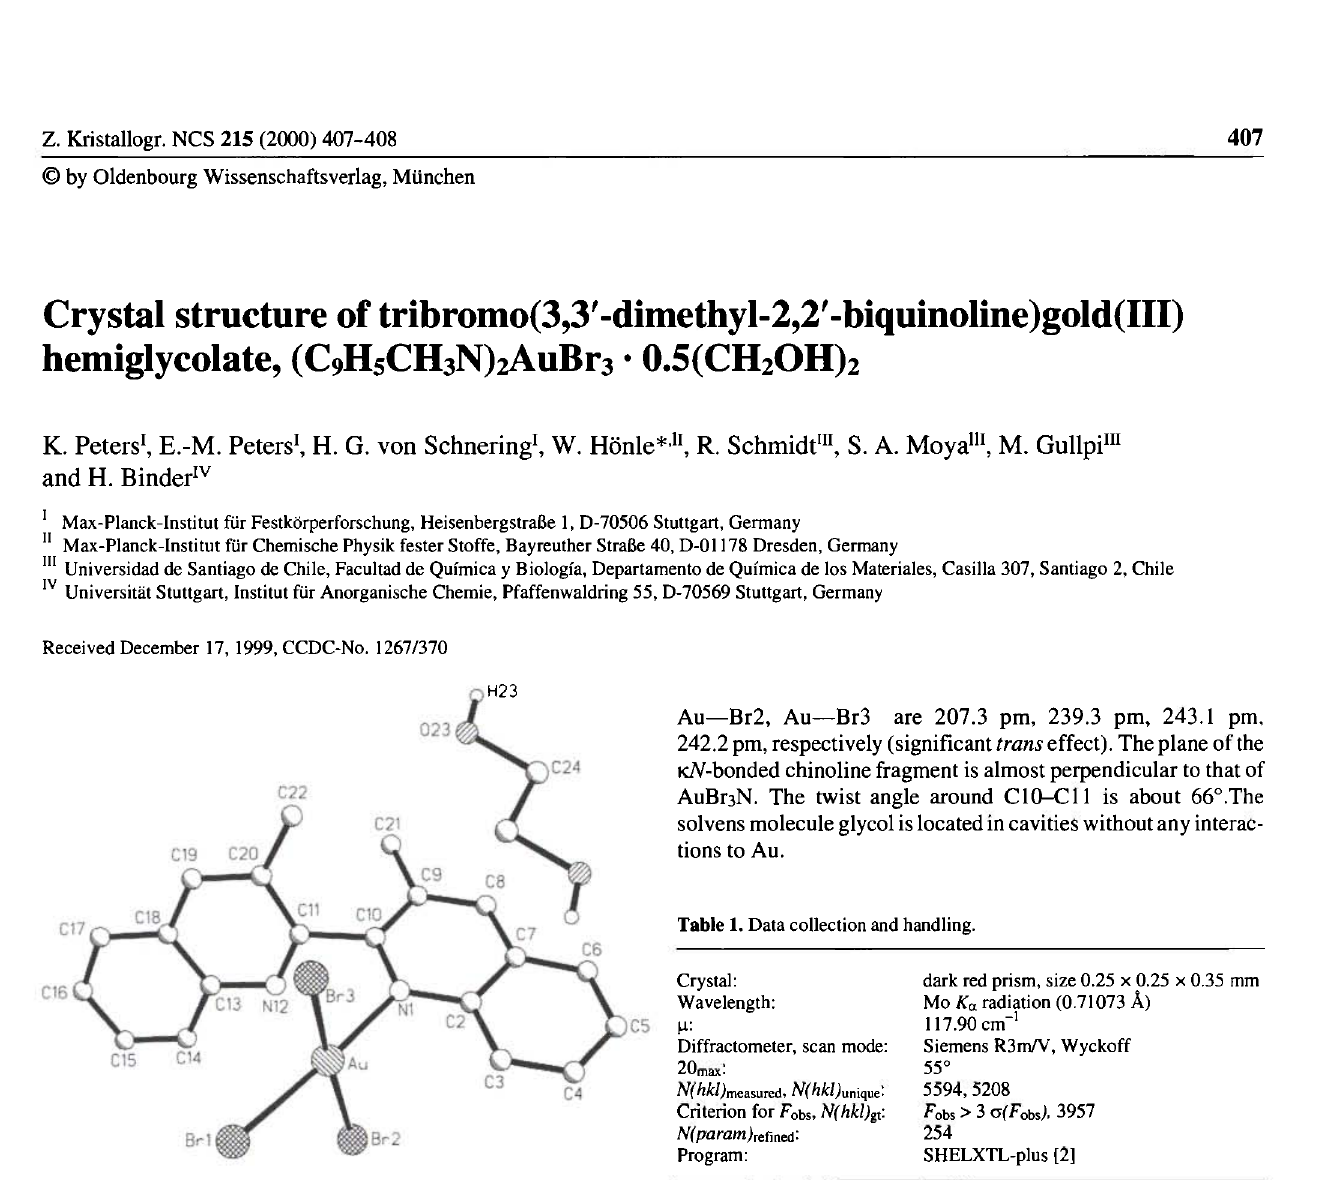
Table 2. Atomic coordinates and displacement parameters (in Ä 2